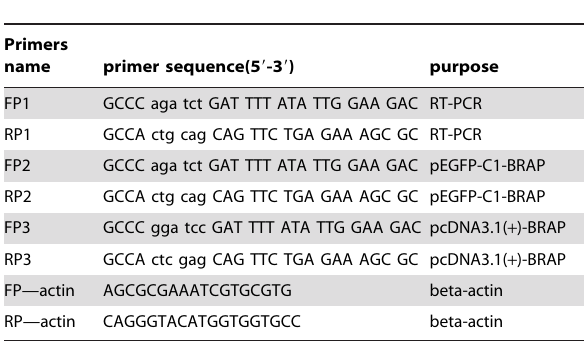
Table 1. Primers used in this